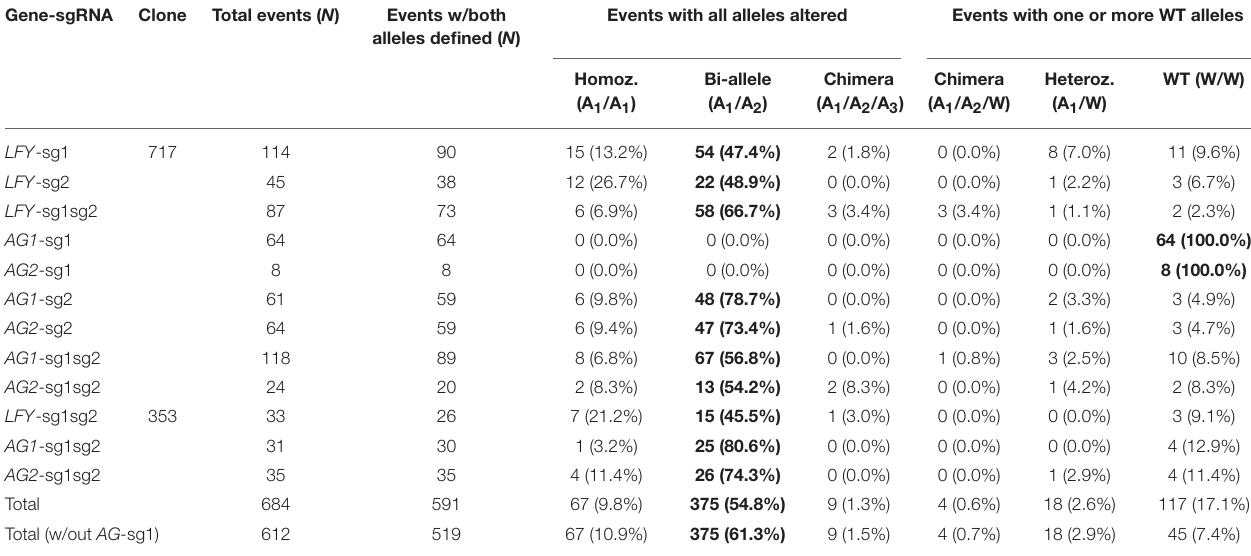
TABLE 1 | Numbers of mutants and rates of mutagenesis according to target gene, sgRNA, and clone. Gene-sgRNA